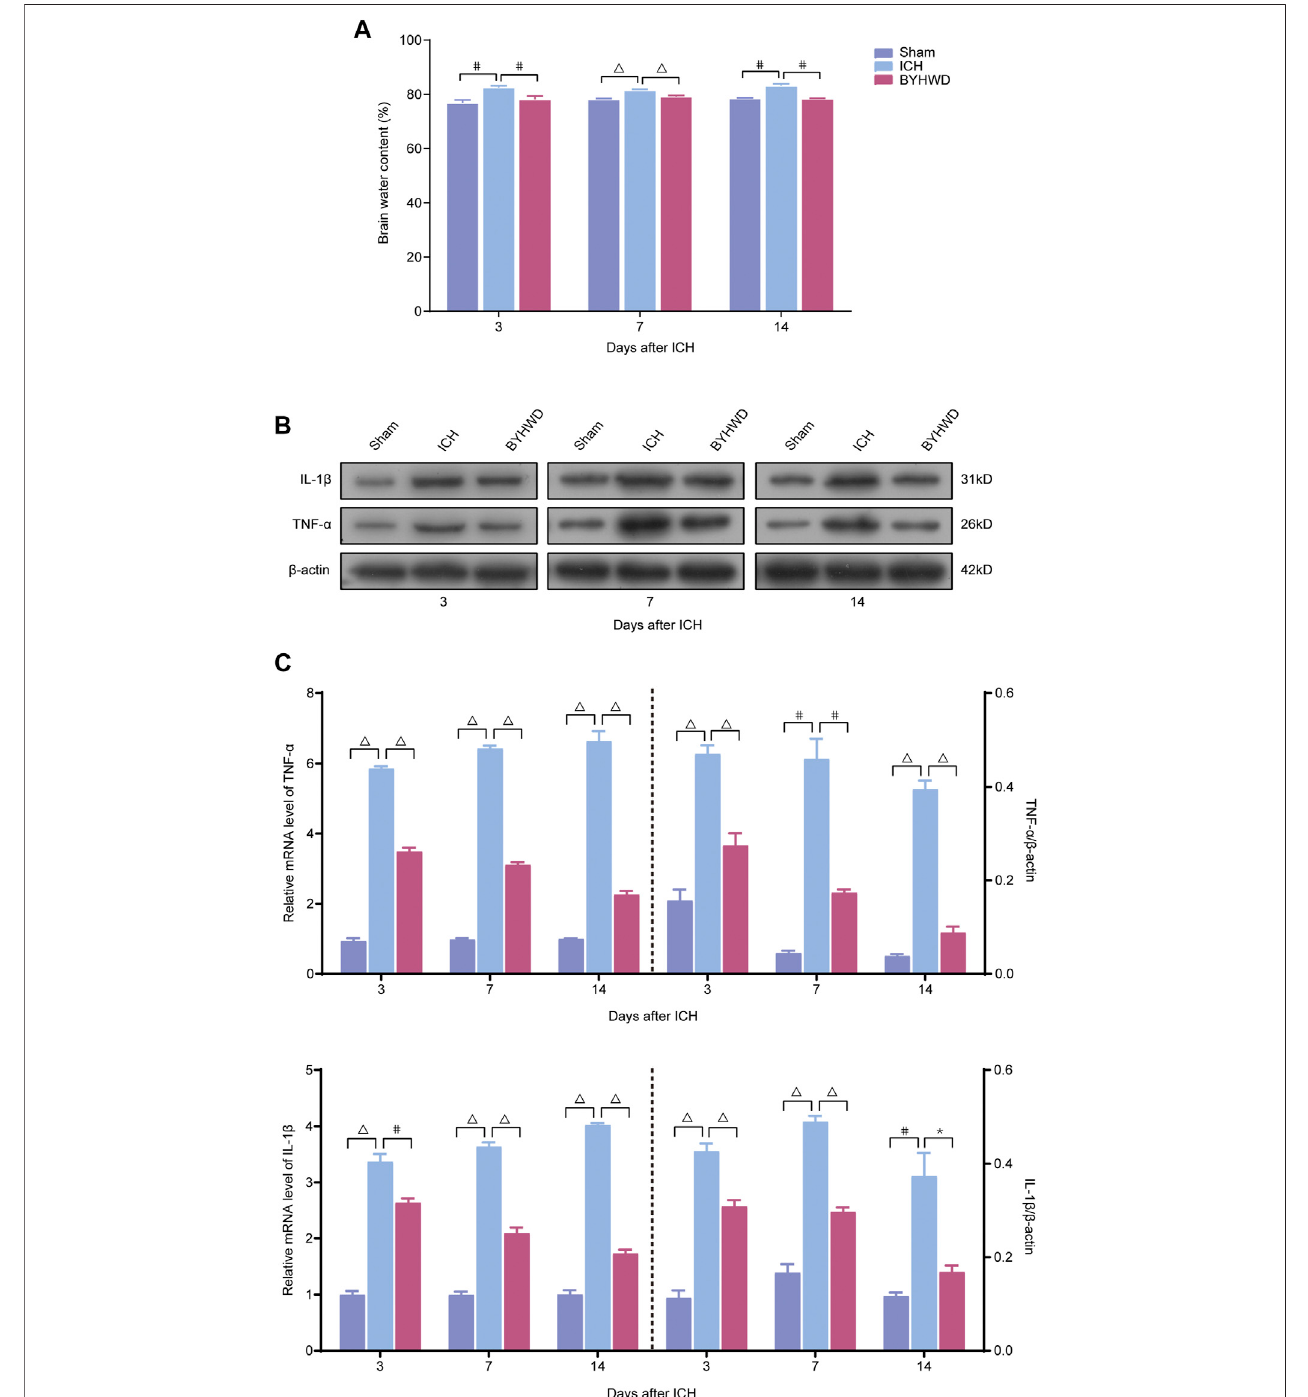
FIGURE2| BYHWD reduced thedegree ofcerebral edemaand downregulated thein fl ammatoryfactors following ICH. Recorded brainwatercontent (A) ondays 3, 7, and 14 after ICH. A representative immunoblot showed the effects of ICH and BYHWD on the protein levels of in fl ammatory factors TNF- α and IL-1 β (B) at the ipsilateral tissue. The left side of the dotted line shows the relative mRNA levels of TNF- α and IL-1 β (C) , respectively. The right side of the dotted line shows the protein levels of TNF- α and IL-1 β (C) , respectively. Levels of TNF- α and IL-1 β mRNAs were dramatically decreased in the BYHWD-treated group after ICH. Western blot analysis also showed that the expression levels of TNF- α and IL-1 β were signi fi cantly downregulated after ICH. BYHWD suppressed in fl ammatory response. Relative TNF- α and IL-1 β levels were calculated based on densitometry analysis. Themean TNF- α and IL-1 β level ofthesham group wasnormalized to1.0. Datawere displayed as mean ± SEM ( n (cid:2) 6 each group); * p < 0.05, # p < 0.01, Δ P < 0.001 deemed as signi fi cant difference.